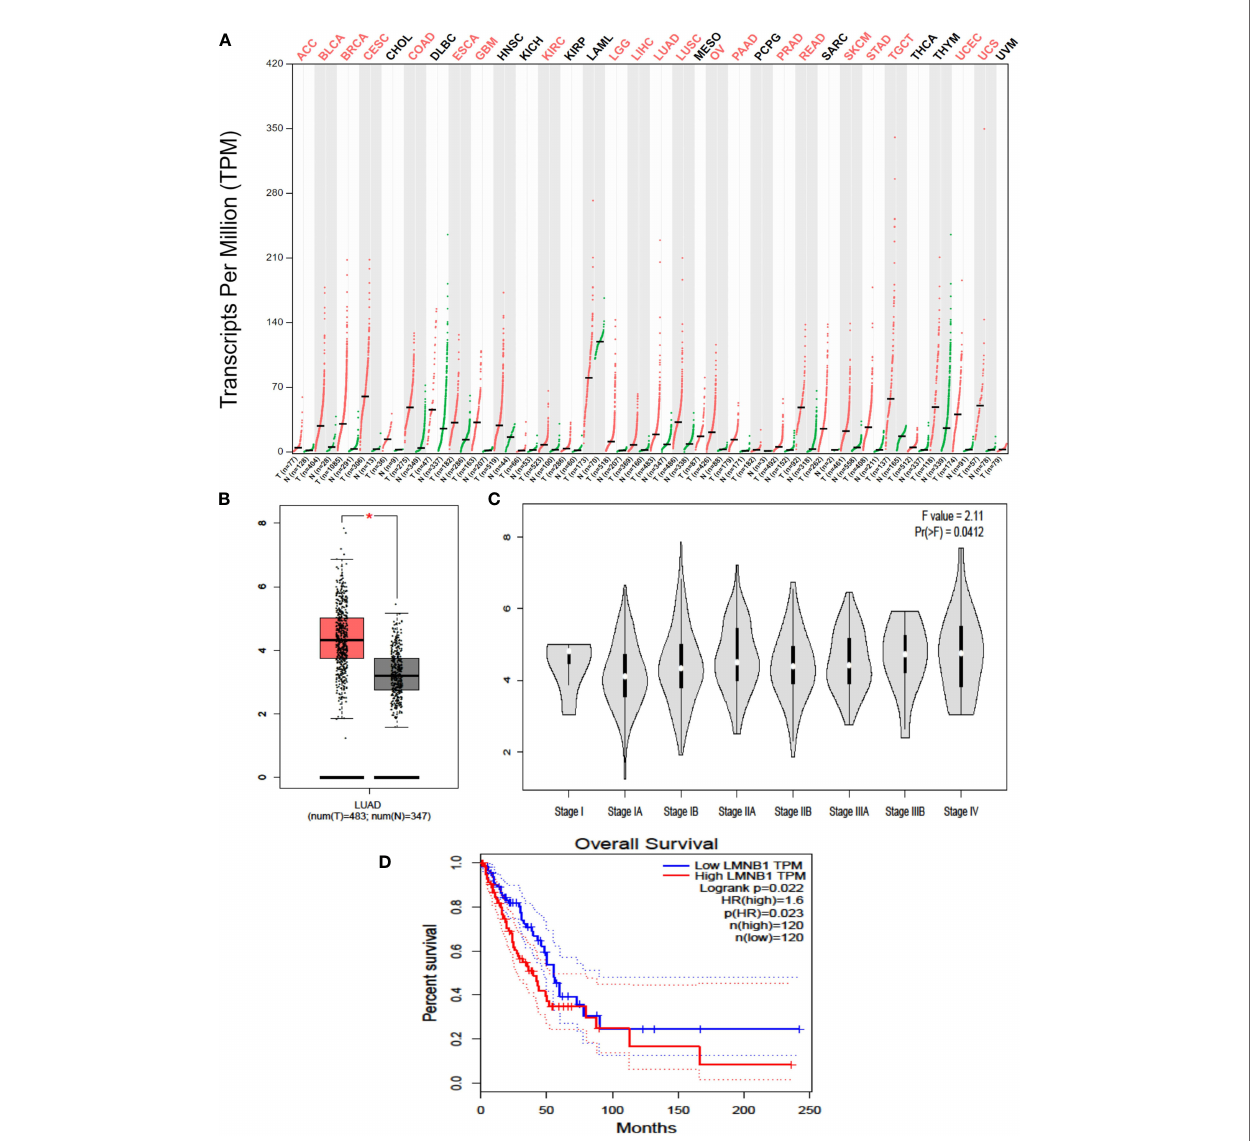
FIGURE 1 | Highly expressed LMNB1 in LUAD cells is associated with tumor stage and overall survival. (A) The LMNB1 expression pro fi le across all tumor samples and paired normal tissues was obtained on the GEPIA website (http://gepia.cancer-pku.cn/). (B) The expression of LMNB1 in the different pathological stages of LUAD patients from TCGA dataset by using bioinformatics ’ analyses. *p<0.05. (C) The expression of LMNB1 at mRNA level in LUAD patients from TCGA and GTEx dataset by using bioinformatics ’ analyses. (D) Overall survival analysis of LUAD patients from TCGA dataset ( P =